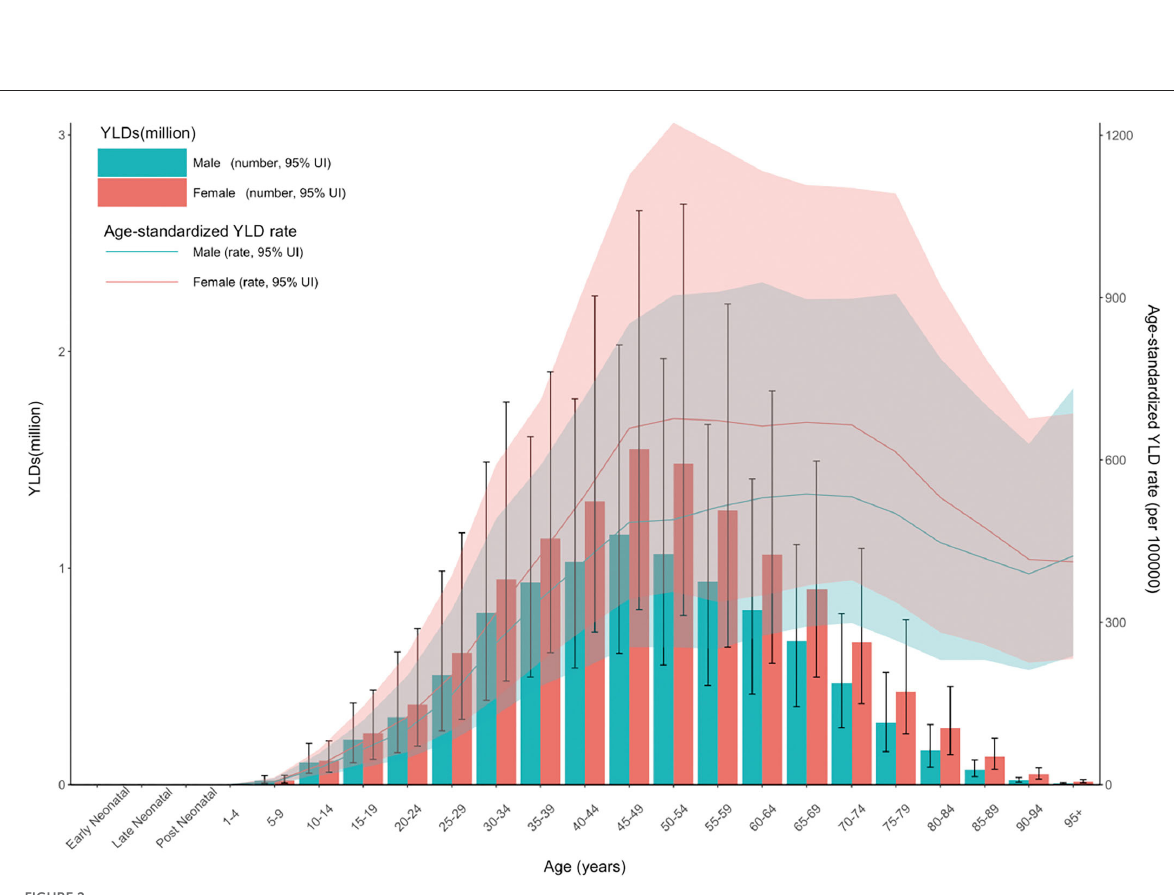
FIGURE2 Age patterns by gender in 2019 for the total YLD number and age-standardized YLD rate of neck pain at the global level. Dashed lines (total YLD number) and transparent areas (age-standardized YLD) indicate 95% upper and lower uncertainty intervals, respectively. Generated from data available at http://ghdx.healthdata.org/gbd-results-tool. YLD, years lived with a